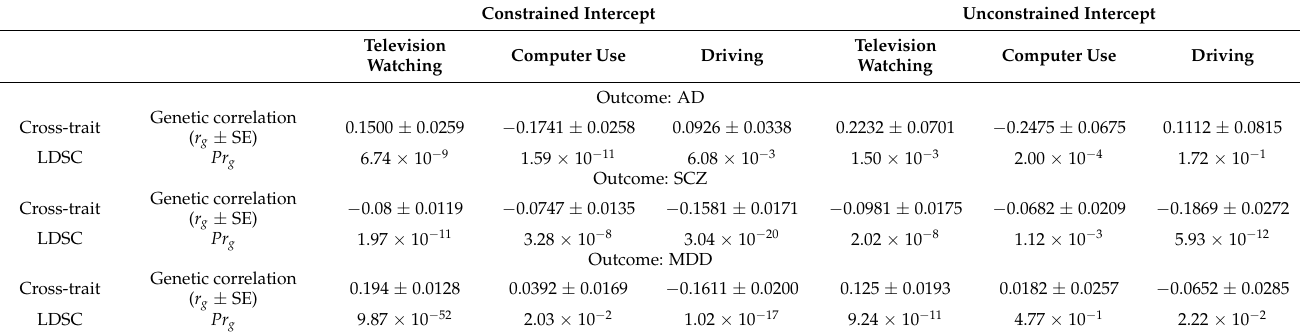
Table 1. Genetic correlation of sedentary behaviors and